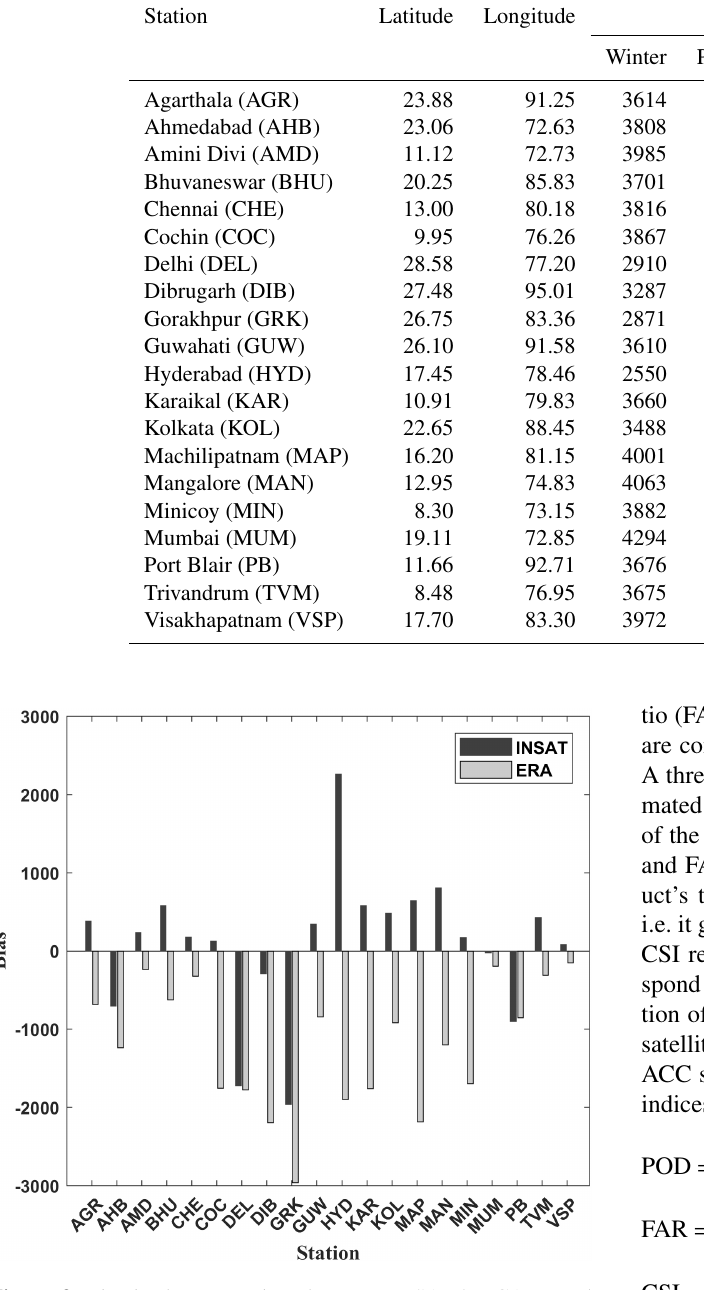
Figure 3. Bias in the comparison between INSAT-3D CAPE and ERA-Interim reanalysis CAPE with radiosonde for different sta- tions in India for the period April 2014–March